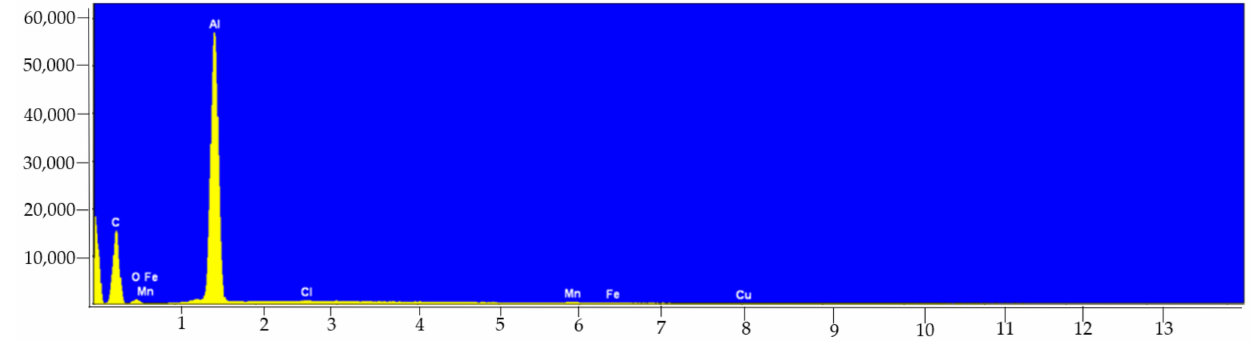
Figure 2. EDS spectrum collected from the surface of aluminum can sample ( ×